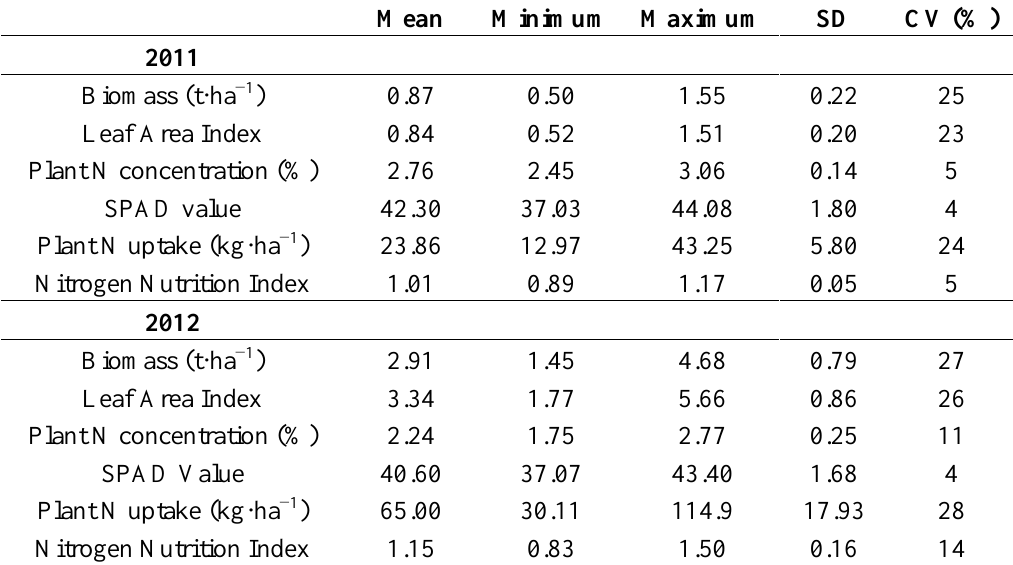
Table 3. Descriptive statistics of rice N status indicators for 2011 (41 field samples) and 2012 (51 field samples), Heilongjiang Province, China.